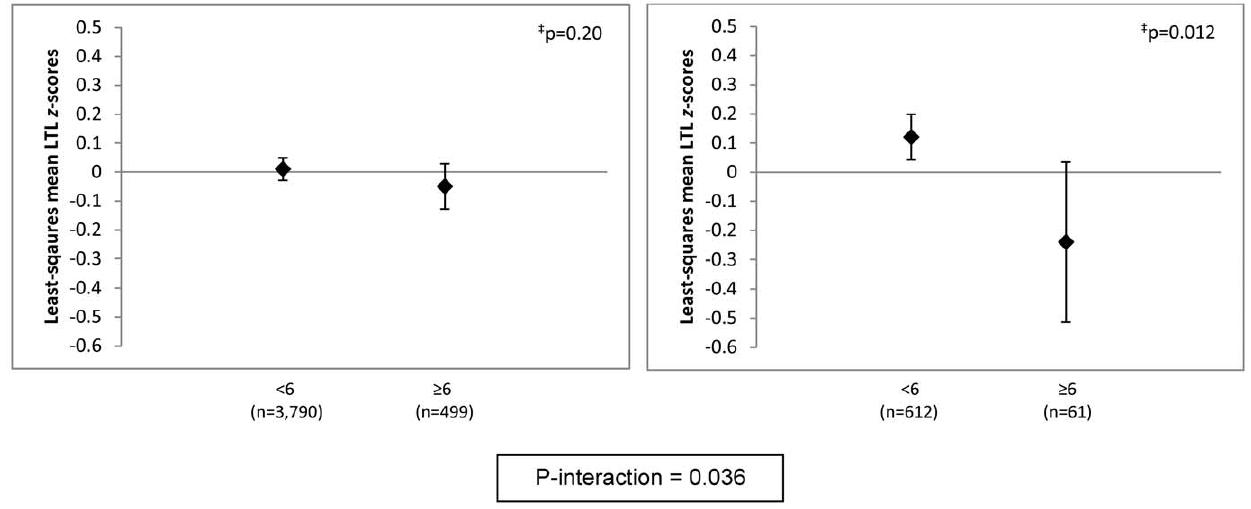
Figure 3. Adjusted* least-squares mean telomere length z -scores, by phobic anxiety level, stratified by paternal age ( , 40 or $ 40 years). *, Models were adjusted for age in years (continuous), pack-years of smoking (0, . 0 to , 20, 20 to , 40, $ 40), body mass index (continuous, kg/m 2 ) and physical activity (continuous, MET-hrs/wk). Least squares means and 95% confidence intervals are shown. N=281 excluded due to missing paternal age. { , P-value for test of difference in least-squares means.